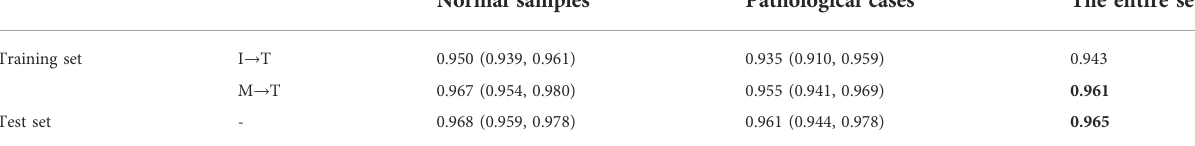
TABLE 2 Training result of cross-modal alignment ( R 2 ).